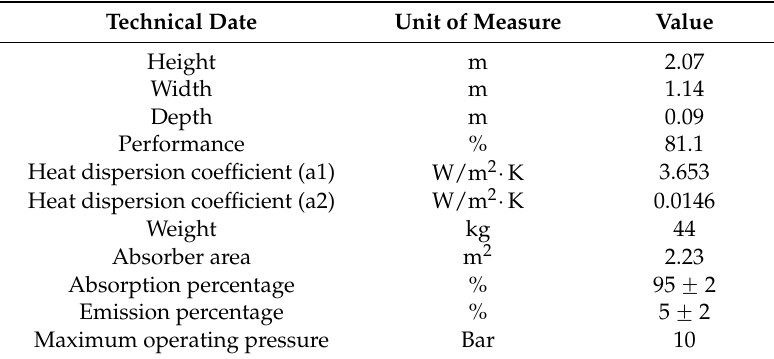
Figure 9. Ex Banco Napoli solar thermal collector system. Table 10. Technical data of the solar collectors used in Ex Banco Napoli.